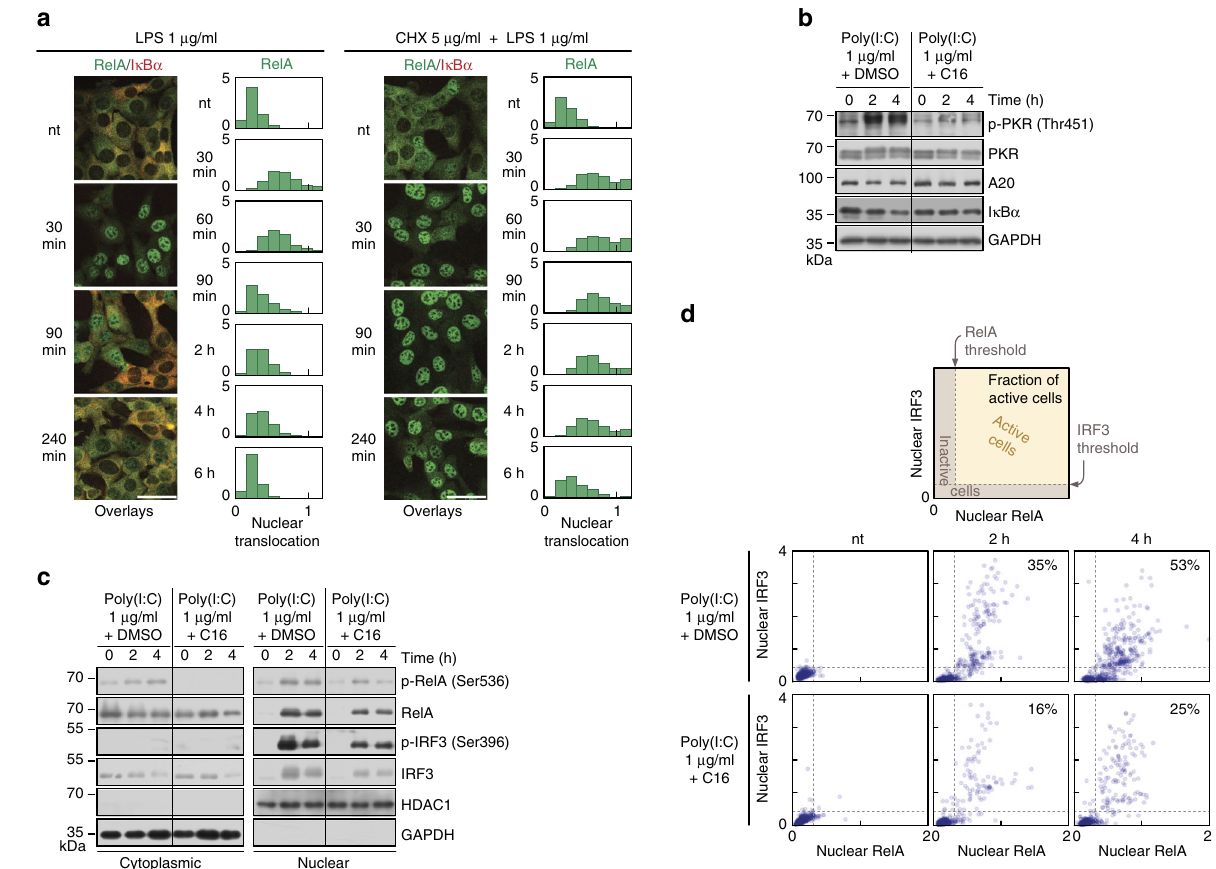
Fig. 5 Inhibition of translation stabilises translocation of RelA and IRF3. a RelA (NF- κ B) translocation and cytoplasmic I κ B α levels in response to LPS or CHX + LPS. WT MEFs were stimulated with 1 μ g/ml LPS in the absence or presence of 5 μ g/ml CHX, fi xed and stained at given time-points with antibodies for RelA and I κ B α . Representative excerpt from confocal images show cells at 0 (nt), 30, 90 and 240 min after LPS stimulation. Histograms ( n ≥ 700, from a representative experiment out of 2) show the full time course of RelA nuclear translocation, de fi ned for Fig. 2. See Supplementary Data 3 for corresponding uncropped immunostaining images. Scale bar: 50 μ m. b – d Protein levels in response to poly(I:C) upon PKR inhibition. WT MEFs were stimulated with 1 μ g/ml poly(I:C) for 0 (nt), 2 and 4 h in the absence or presence of imidazolo-oxindole PKR inhibitor (1 μ M/ml), C16, added at 1 h prior to poly(I:C) transfection. Culture medium for all conditions contained the C16 solvent DMSO (0.5% fi nal concentration), and was FBS-free to prevent interference with C16. b Whole-cell extracts were analysed using antibodies against total PKR, A20 and I κ B α , as well as against a phosphorylated (active) form of PKR (p-Thr451). c Nuclear and cytoplasmic fractions were analysed using antibodies against total RelA and IRF3, as well as against their phosphorylated (active) forms, p-RelA (Ser536) and p-IRF3 (Ser396). d Cells were fi xed and immunostained for RelA and IRF3. Scatter plots show nuclear translocations of RelA vs. IRF3 ( n = 500) based on confocal images analysis. Percentages indicate fractions of active cells; activity was de fi ned by responding (see also Fig. 2b) with both RelA and IRF3 translocation, as illustrated in a mock plot at the top. See Supplementary Data 4 for corresponding